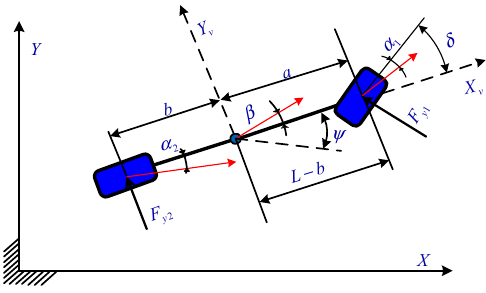
Figure 2. Two-degrees of freedom vehicle model.